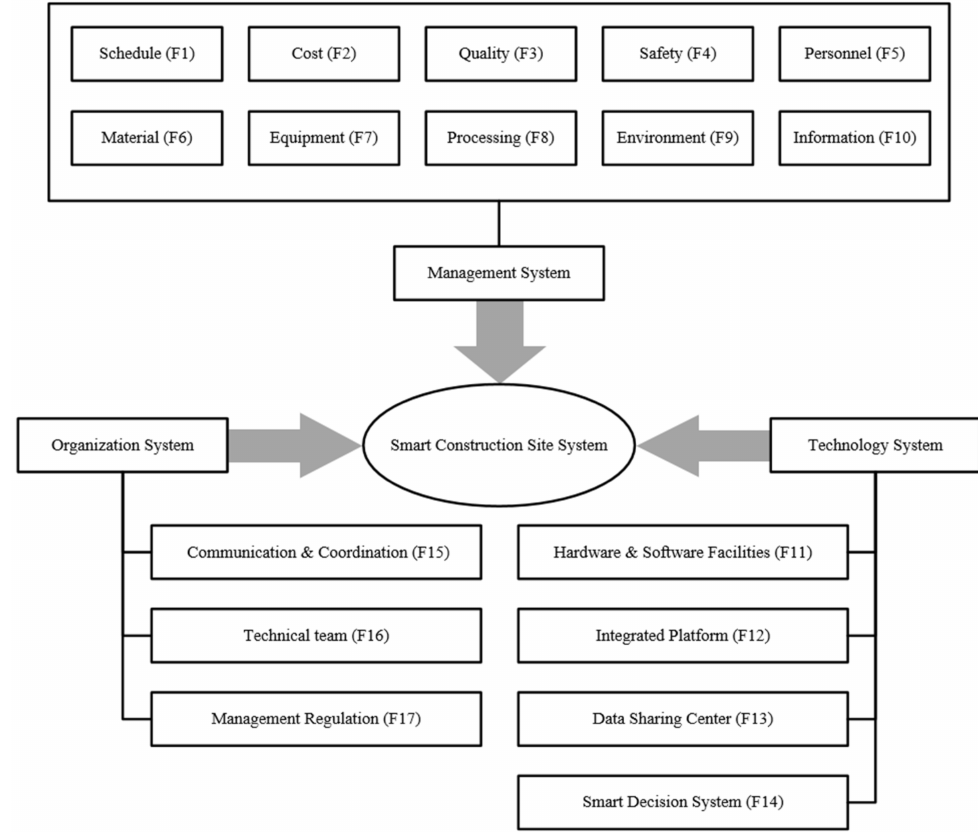
Figure 1. The framework of a smart construction